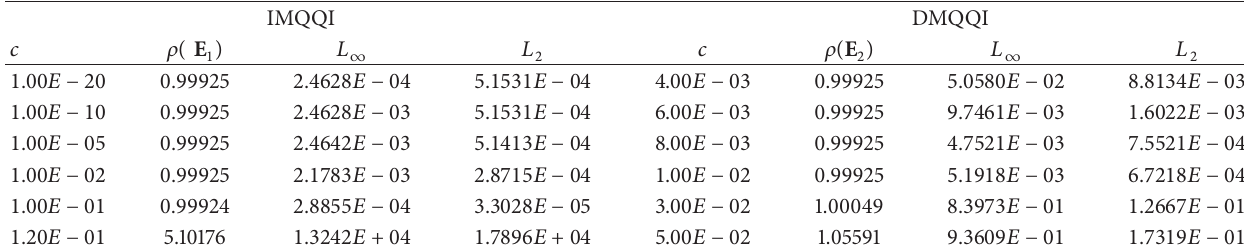
Table 4: The spectral radius and 𝐿 ∞ and 𝐿 2 error norms versus shape parameter 𝑐 when Δ𝑡 = 0.001 , 𝑁 = 100 , and 𝜐 = 0.01 at 𝑡 = 1 of Experiment